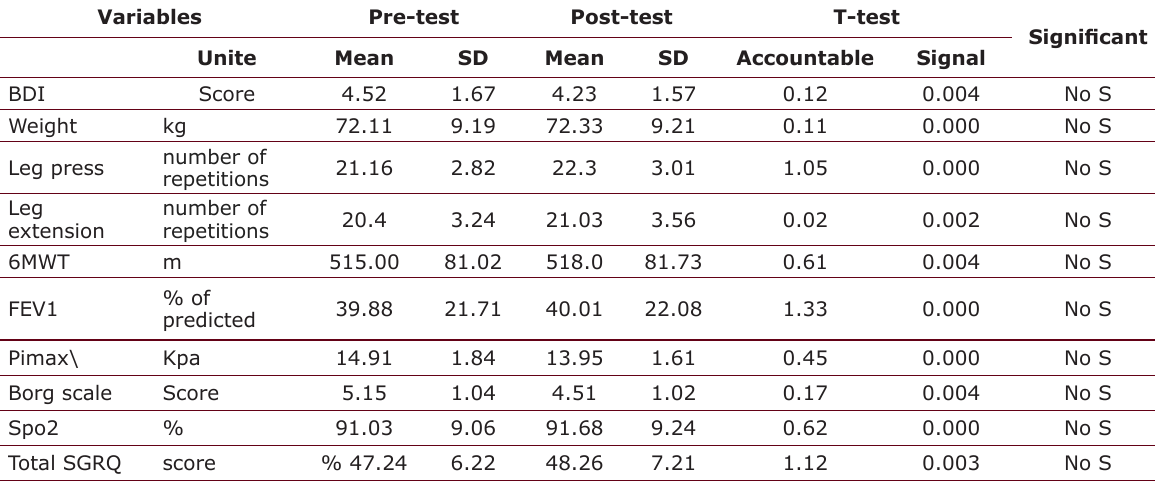
Table 5. The Mean, SD, T-test, signal, and Significant of Pre and post-tests for the control